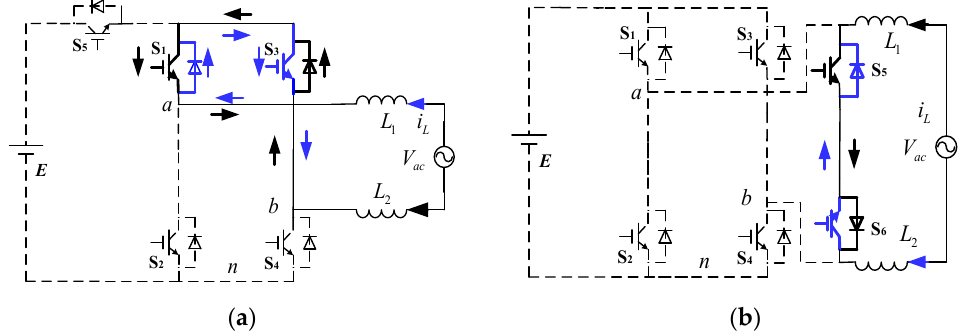
Figure 7. Freewheeling mode in the positive half period with the new hybrid modulation mode (HMM) for both unitary and non-unity power factor. ( a ) H5 grid-tied inverter. ( b ) HEIRC grid-tied inverter.